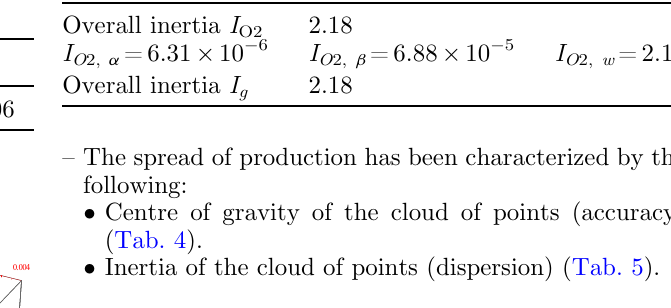
Table 5. Components of inertia of spread of production.